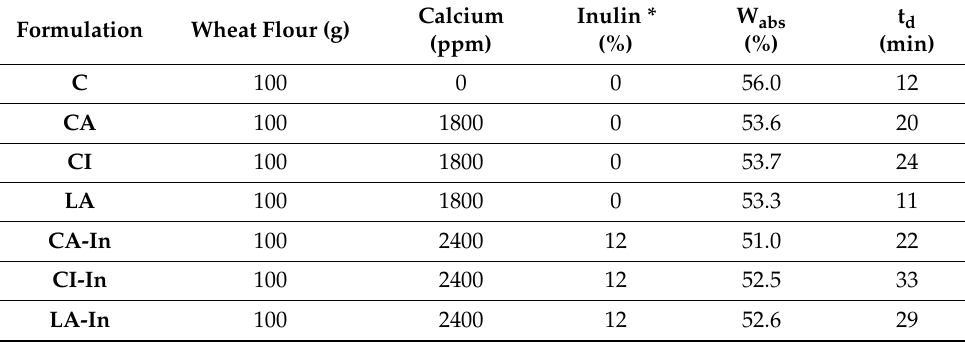
Table 1. Formulations and farinographic parameters of